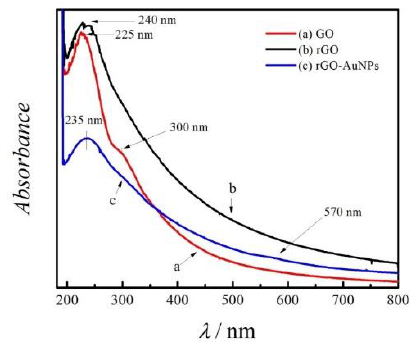
Figure 4. UV-vis spectra for the following nanomaterials (a) GO, (b) rGO and (c) rGO-AuNPs.